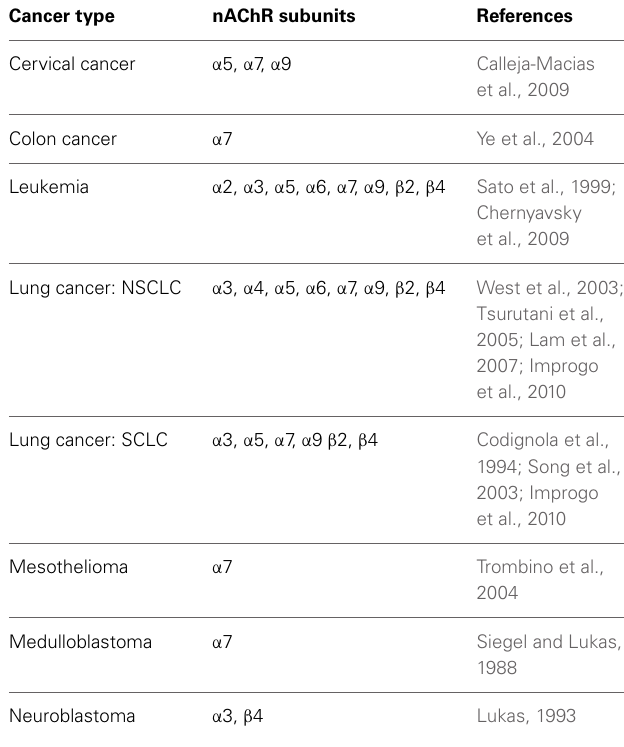
Table 2 | Types of cancer cells expressing nAChR